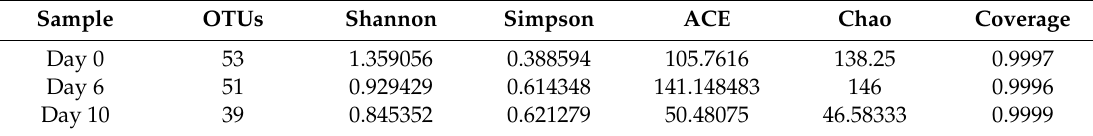
Table 3. Phylotype coverage and alpha diversity estimation of bacterial communities in hybrid grouper fillets during storage at 4 °C.